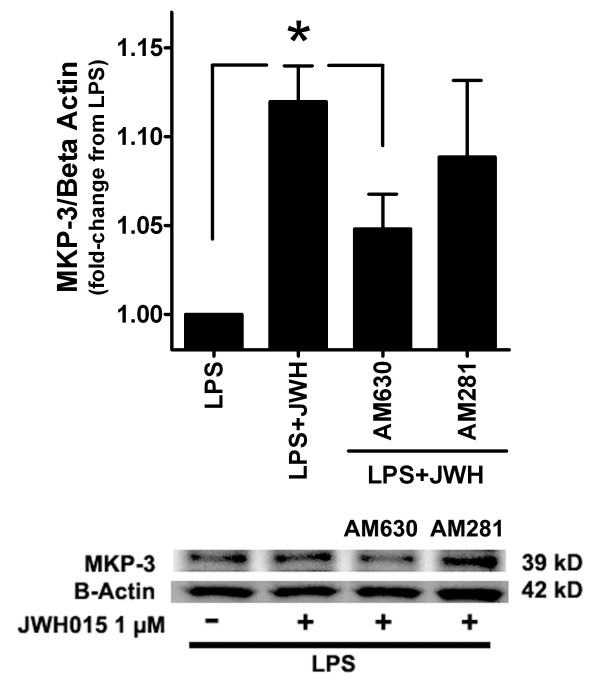
Blockade of CBR2 antagonizes the MKP-3 induction by JWH015. Quantification and representative western blot of MKP-3 expression in LPS-stimulated microglia in the presence or absence of JWH015 (1 μM) with or without the CBR2 antagonist, AM630, or the CBR1 antagonist, AM281. JWH015 induced a significant increase in MKP-3 compared to the LPS alone groups at the 15 min incubation time point. However, AM630 significantly blocked JWH015's effects on MKP-3 expression. JWH015's effects on MKP-3 were not modified by AM281. *p < 0.05 vs. LPS alone and LPS + JWH015 1 μM groups.